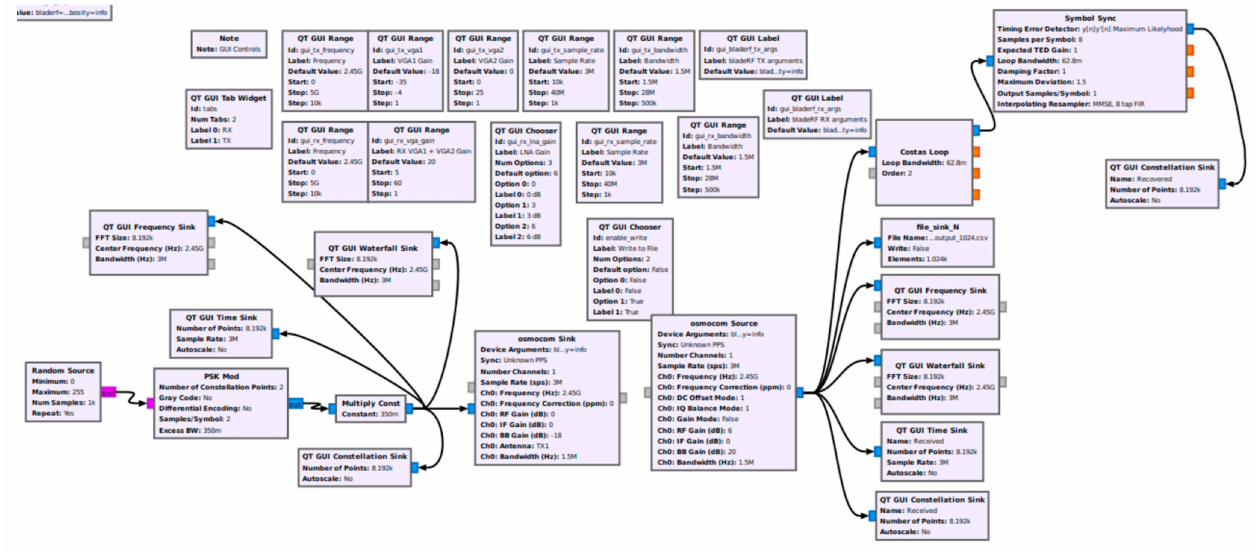
Figure 4. BPSK modulation/demodulation